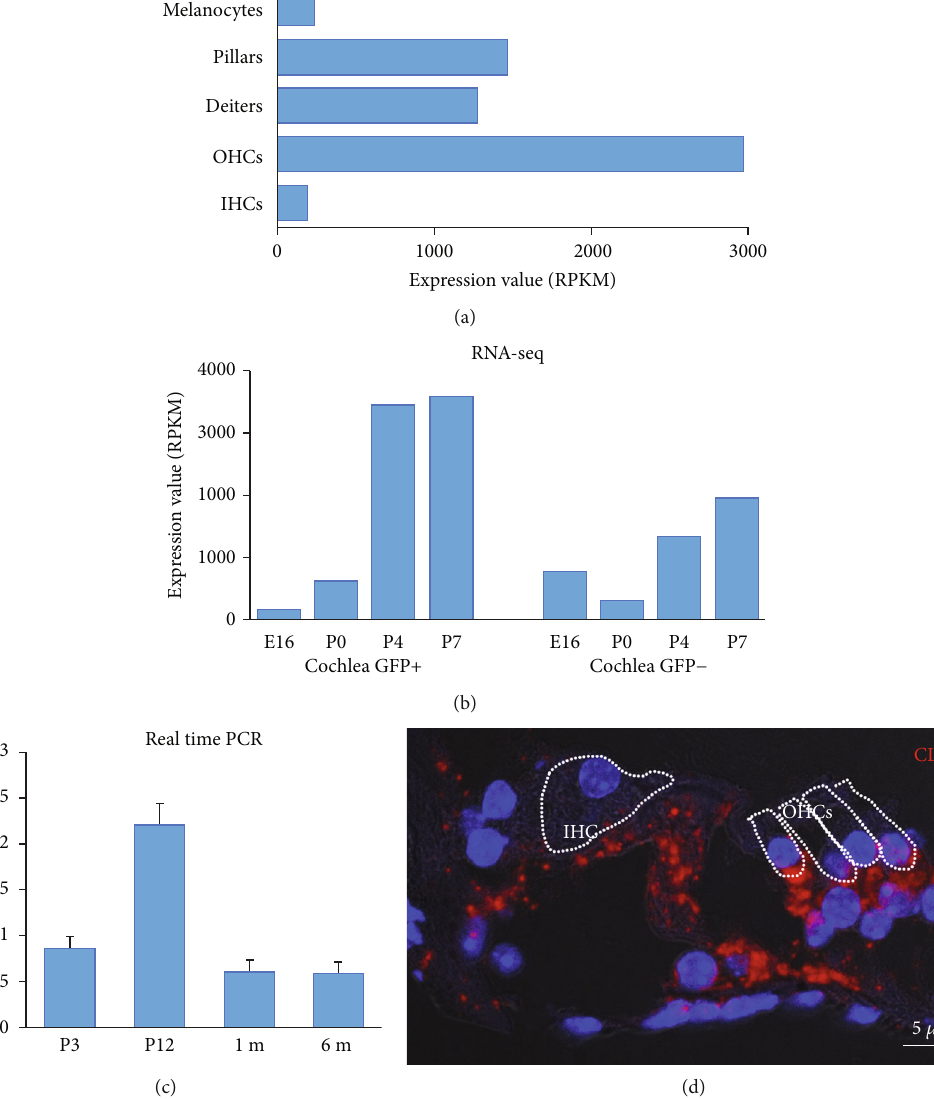
Figure 2: Clu expression in the organ of Corti of the cochlea. (a) RNA-seq in the adult CBA/J mouse cochlea showed Clu expression in OHCs, IHCs, pillar cells, Deiters ’ cells, and melanocytes, with strong expression in OHCs. (b) RNA-Seq examining gene expression during mouse inner ear development showed Clu expression in hair cells (GFP + ) and supporting cells (GFP − ) in the mouse cochlea, from E16 to P7. (c) Temporal expression patterns of Clu mRNA in the mouse inner ear. Clu mRNA transcripts were strongly expressed at P12, with slight but signi fi cantly decreased expression with aging. N = 4 . (d) In situ hybridization performed in the WT cochlea at P21 showed Clu expression in OHCs and stronger expression in the pillar and Deiters ’